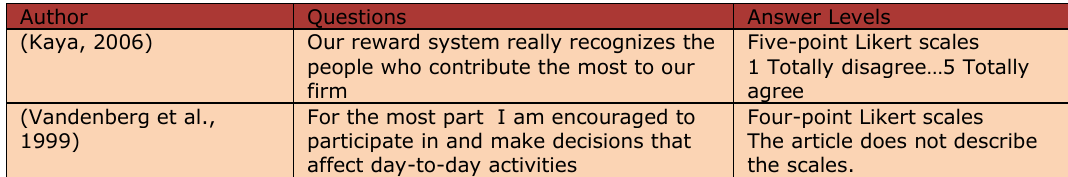
Tabla 4. Question samples from type B